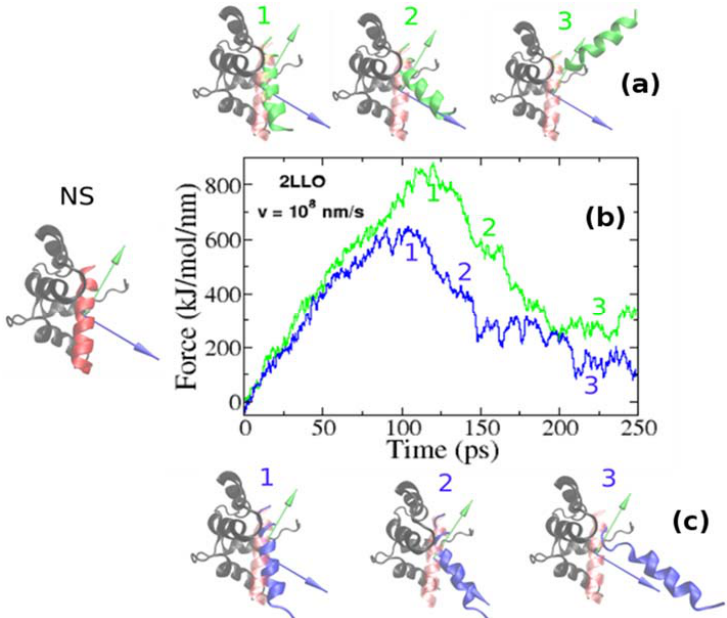
Figure 2. Examples of force ‐ extension profiles for 2LLO complex pulled in different directions(b). Green and blue colors refer to the resultant dipole moment (RDM) and COMs pulling directions, respectively. The native conformation of 2LLO is shown on the left (marked by NS) with ligand colored red and receptor colored black. Representative snapshots of pathways for the mechanical unfolding along COMs and RDM directions are shown at the top(a) and bottom(c), respectively. In representative snapshots, we show the position of ligand in native conformation in transparent red.